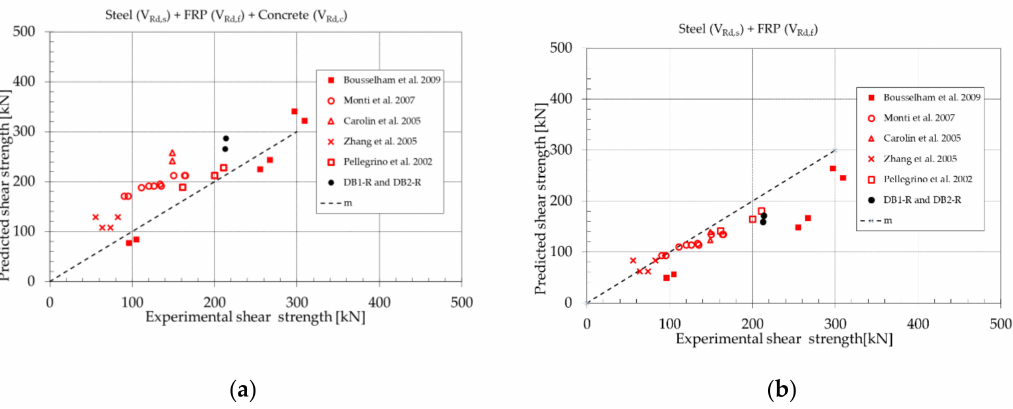
Figure 11. Beam after retrofitting: experimental and predicted shear strength values including ( a ) or not including ( b ) the concrete contribution (V Rd,c ).